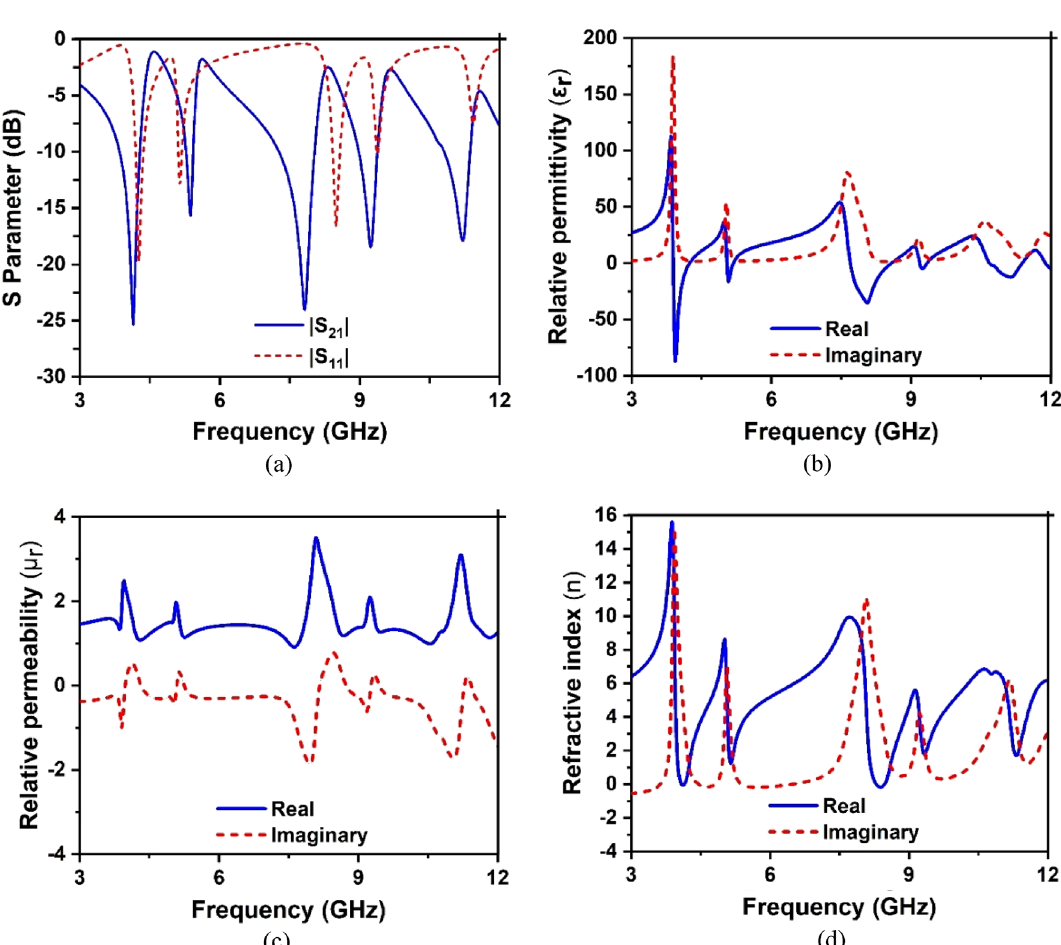
Figure 10. Scattering parameters for evolution steps towards the proposed unit cell: ( a ) S-parameter, ( b ) relative permittivity, ( c ) relative permeability, and ( d ) refractive